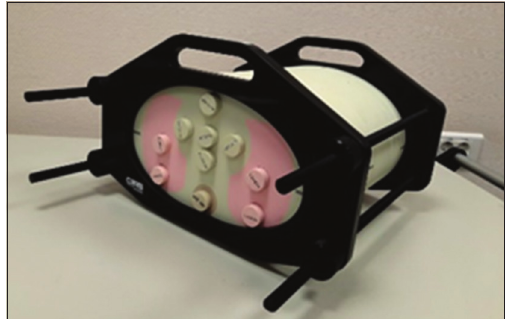
FIGURE 2. Thorax 002LFC phantom.